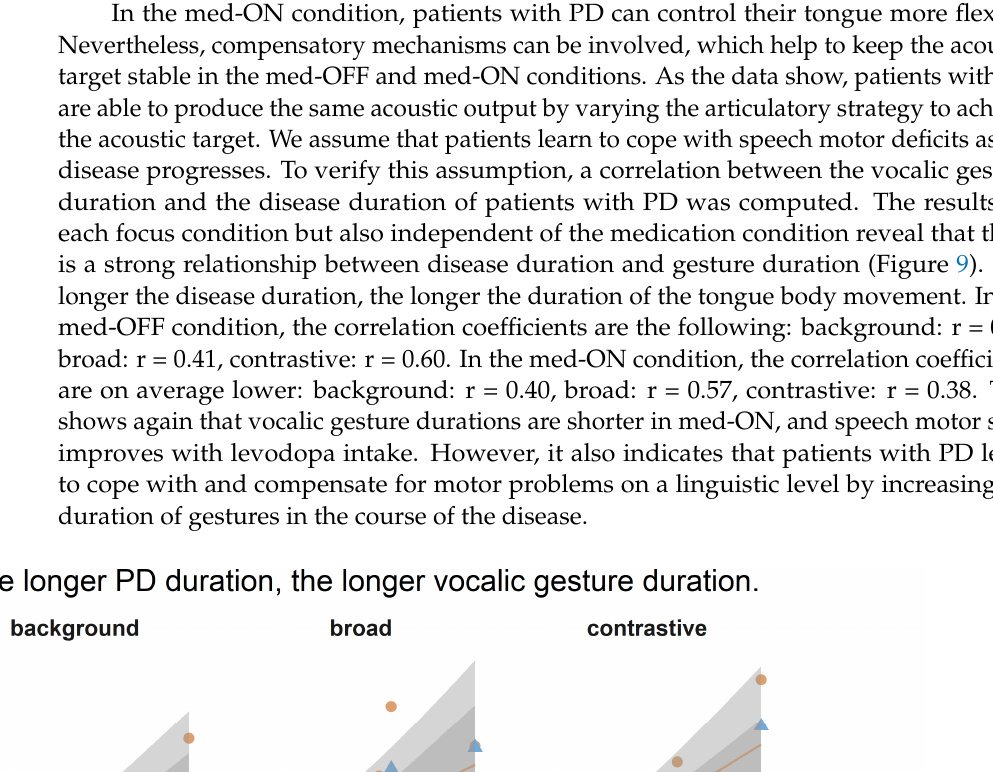
Figure 8. Schematized summary of results with respect to vowel articulation.